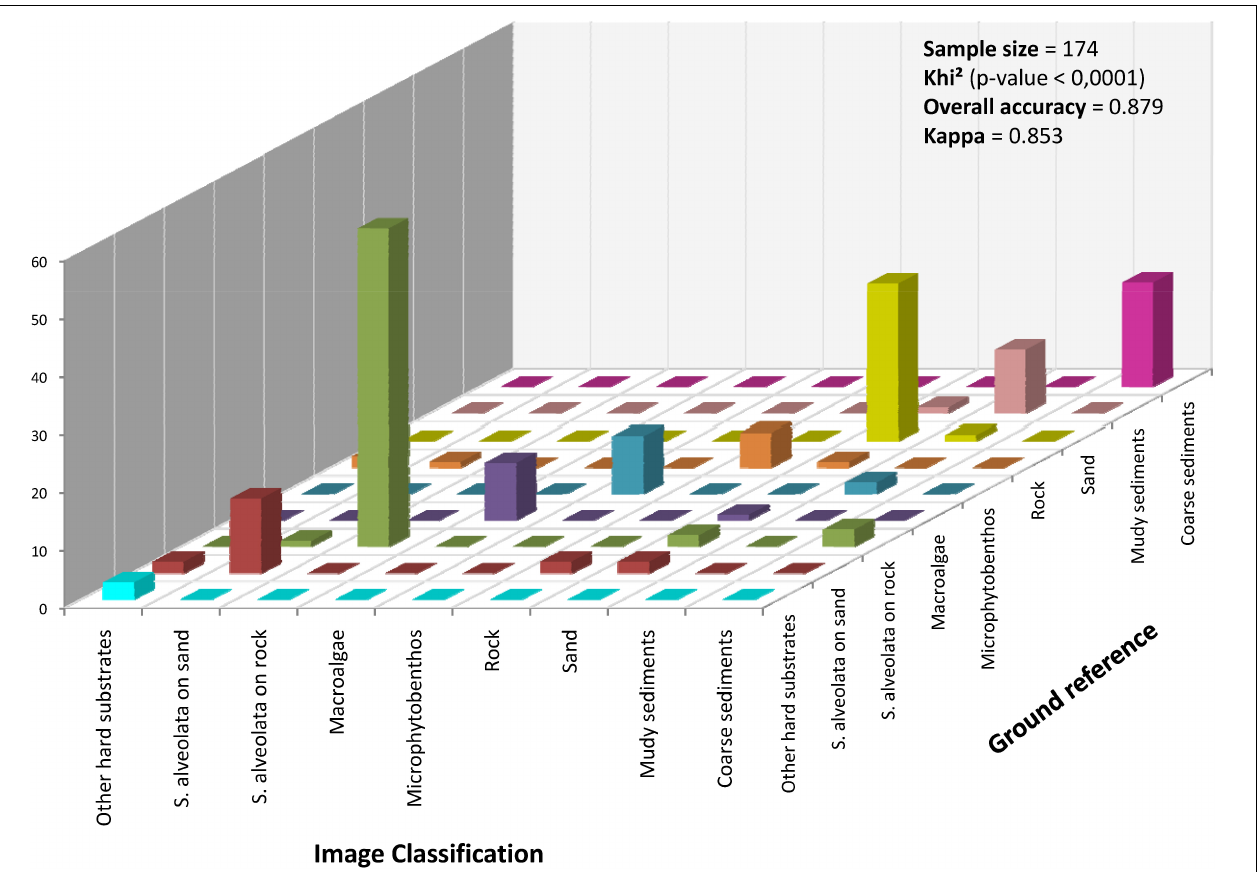
FIGURE 7 | Accuracy assessment of the hyperspectral image classification based on Mahalanobis distance. The height of the bars in the diagonal indicates the number of samples correctly